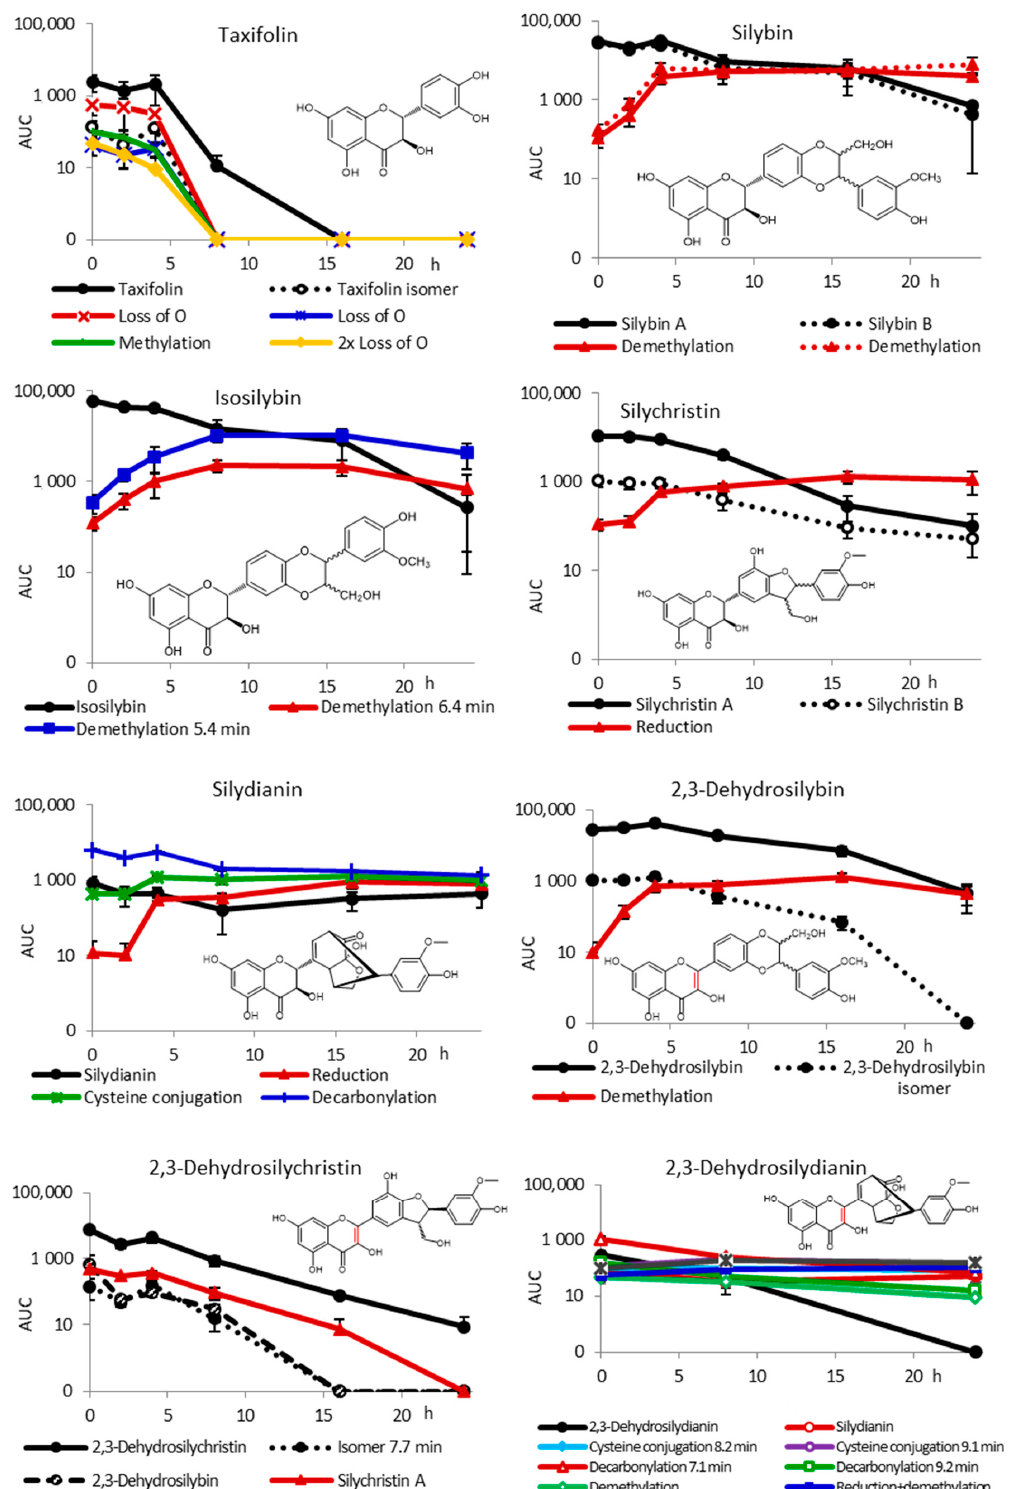
Figure 3. Biotransformation of silymarin components (10 mg/L) by human fecal microbiota from four healthy donors without pre-incubation under simulated gastric and subsequently small-intestinal conditions. The results are shown as the area under the curve (AUC) of the respective peak in LC/MS chromatograms (logarithmic scale) as a function of time of incubation (mean ± SEM, n = 4); minor metabolites with AUC < 1% were excluded for better clarity.